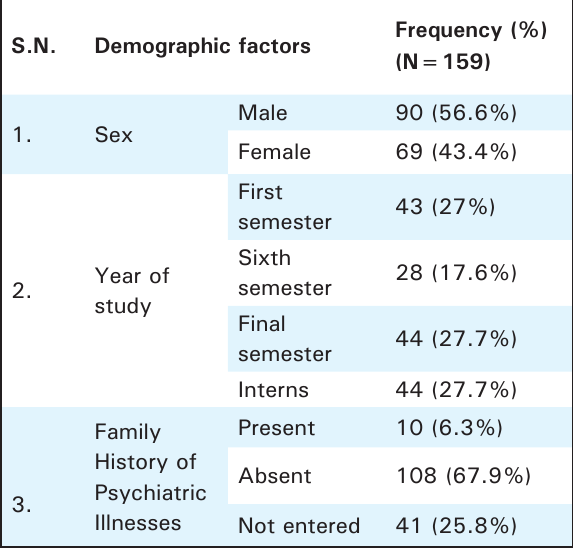
Table 1. Demographic pro fi le of the subjects participating in the